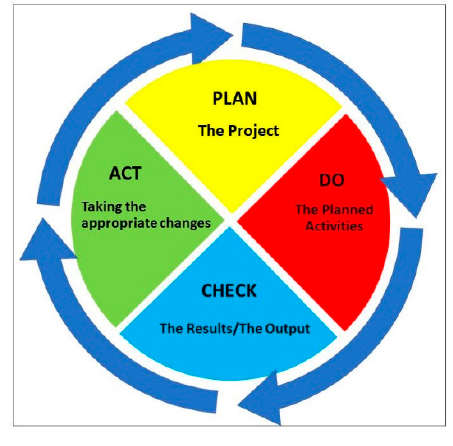
Figure 3. Deming Cycle.